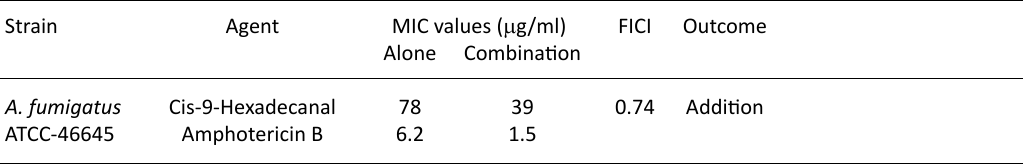
Table 3. Minimum inhibitory concentration (MIC) and fractional inhibitory index (FICI) of cis-9-hexadecenal and amphotericin B against A. fumigatus